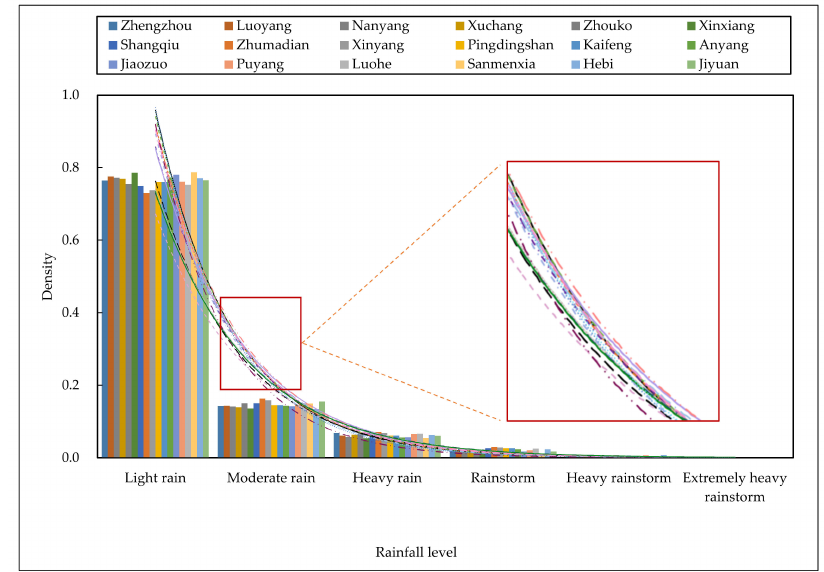
Figure 3. Probability distribution of rainfall grades in cities of Henan